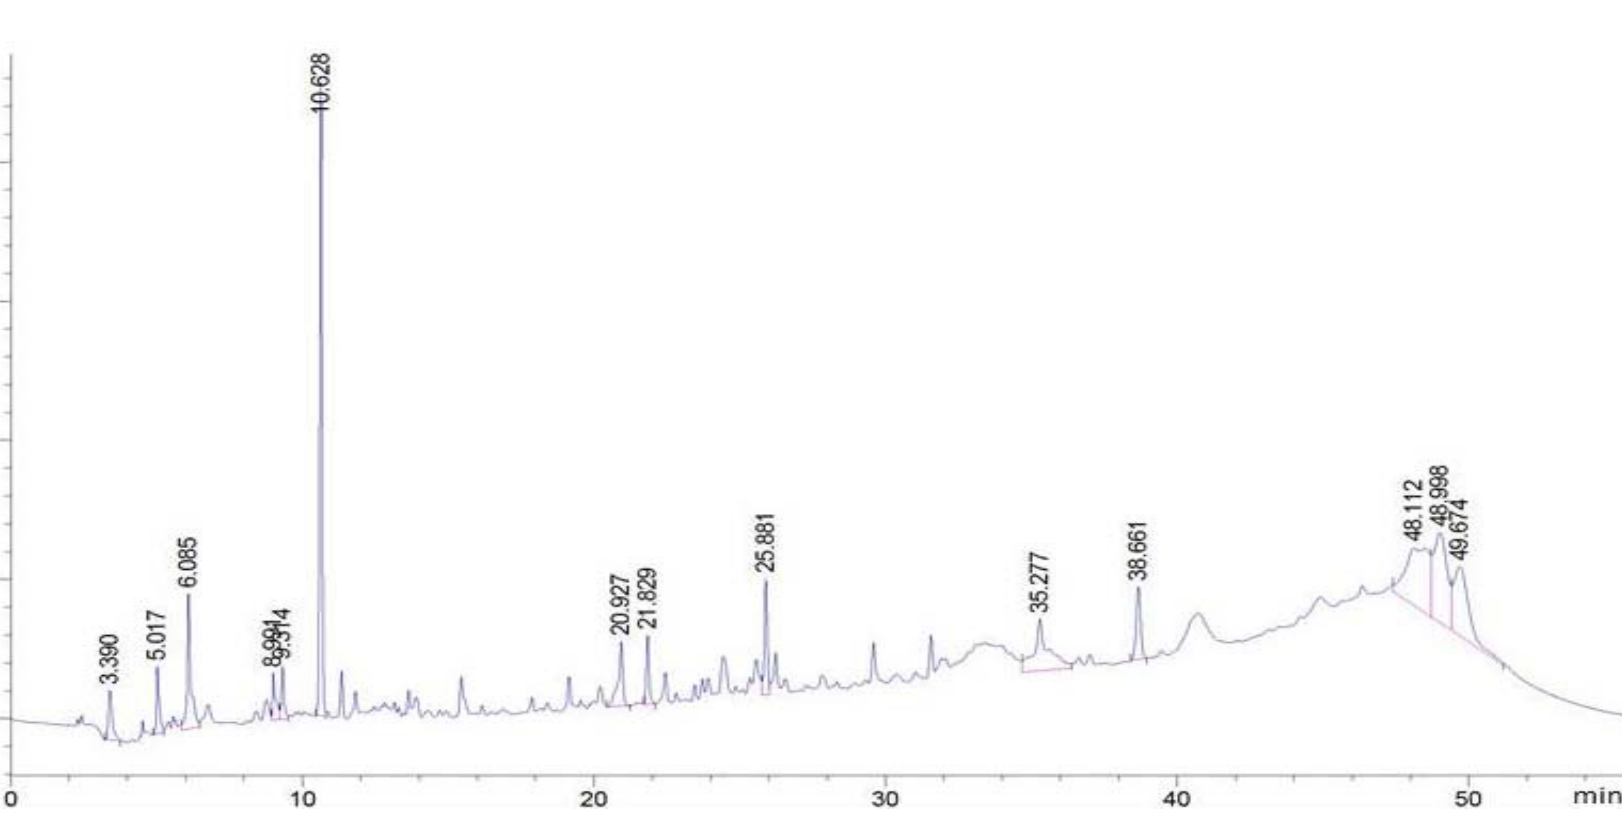
Figure 12. High performance liquid chromatography (HPLC) chromatograms of phenolic extracts from the leaves of H. zenkeri recorded at 280 nm (TR: 19.10: 3,4-OH benzoic acid; 33.49: apigenin; 25.67: caffeic acid; 23.48: catechine; 29.43: eugenol; 14.38; gallic acid; 25.11: O -coumaric; 21.91:OH-tyrosol; 30.52: P -coumaric acid. 42.19: quercetin; 29.45: rutin; 25.55: syringic acid; 17.35: theobromine; 21.77: tyrosol and 25.27: vanillic